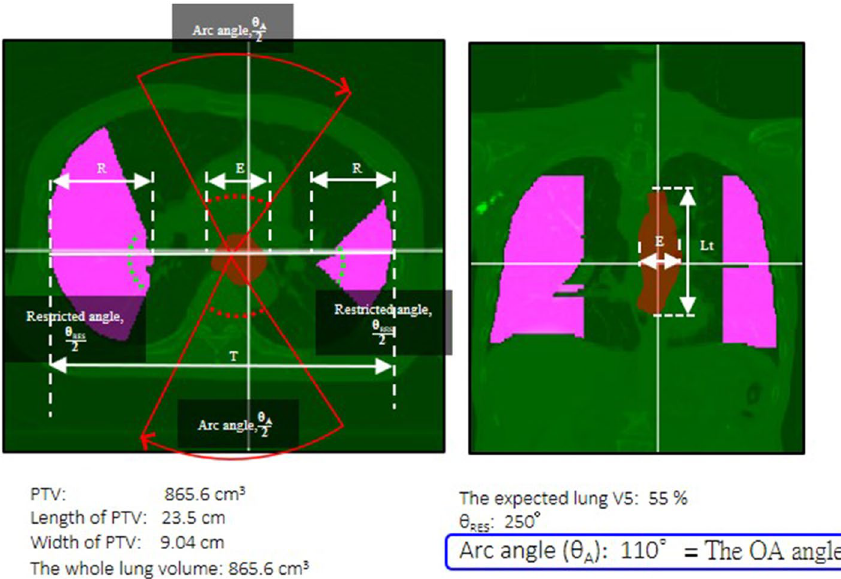
Figure 2. Sample patient for calculating the OPA angle in VBA. The axial and coronal views are shown on the VBA interface. The PTV (red area), length and width of PTV, lung volume, and the expected lung V 5 were shown as input. When the lung V 5 was less than 55%, the θ A was 110° (solid red line), indicating an OPA angle of 110° for this patient. The pink area is restricted